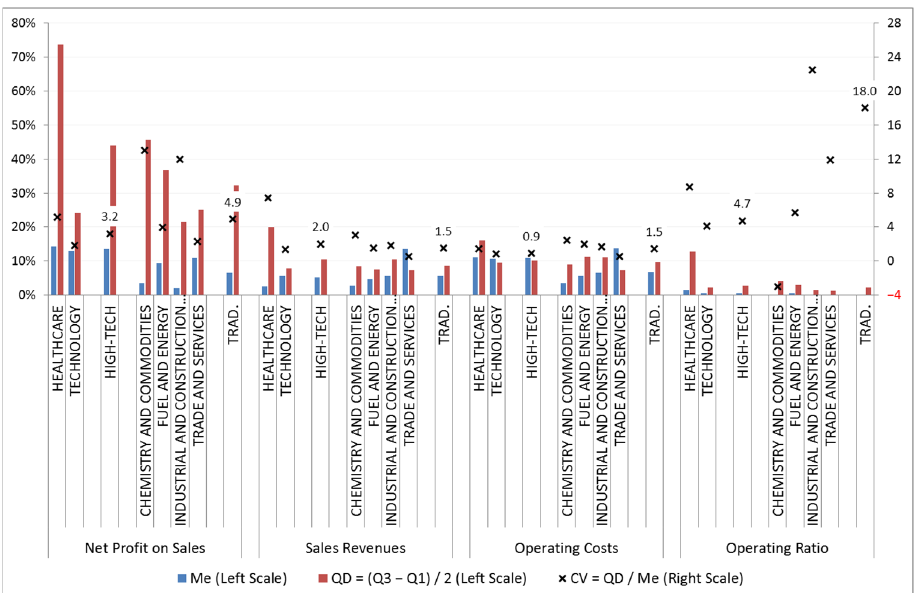
Figure 18. Assessment of variation in the area of result on sales in the analysed sectors. Source: own work.